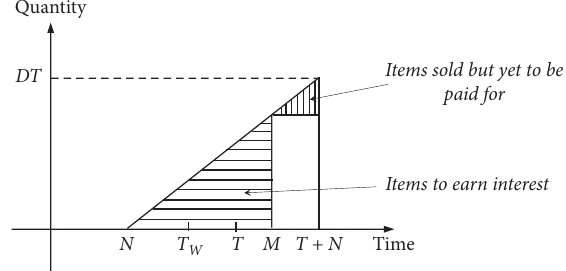
Figure 2: The earned and payable interest of the retailer when M − N ≤ T . T W ≤ Figure 3, the retailer does not bear any payable interest and accumulates pI e D ( M − T /2 − N ) revenue from N to M .